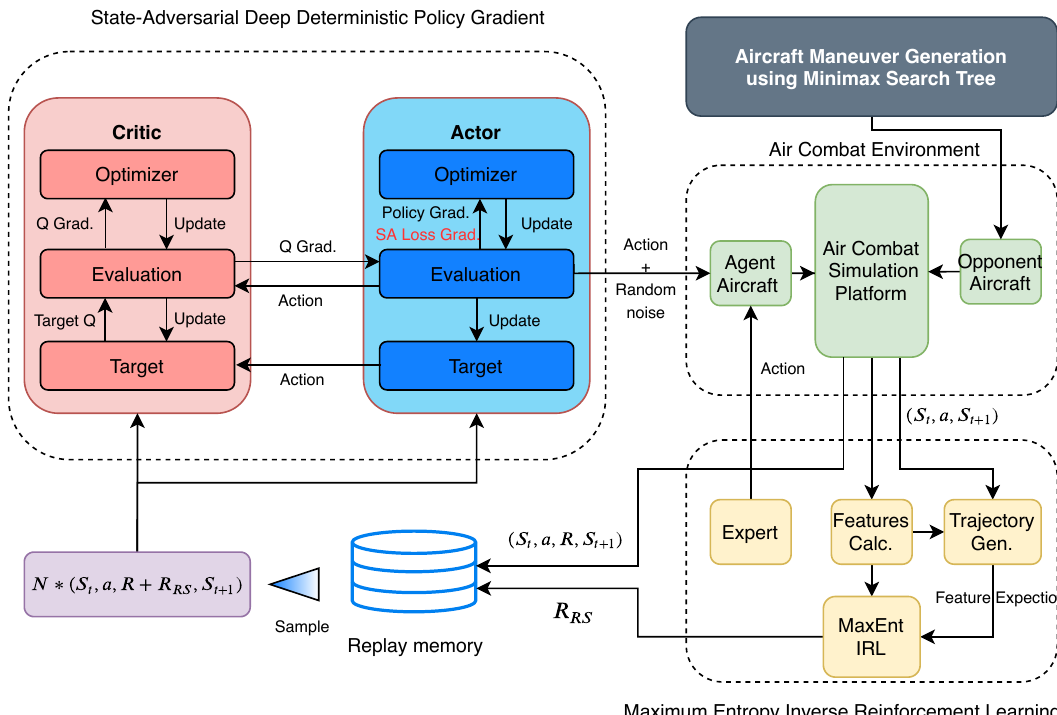
Figure 3. Aerial combat maueuvering strategy generation algorithm using